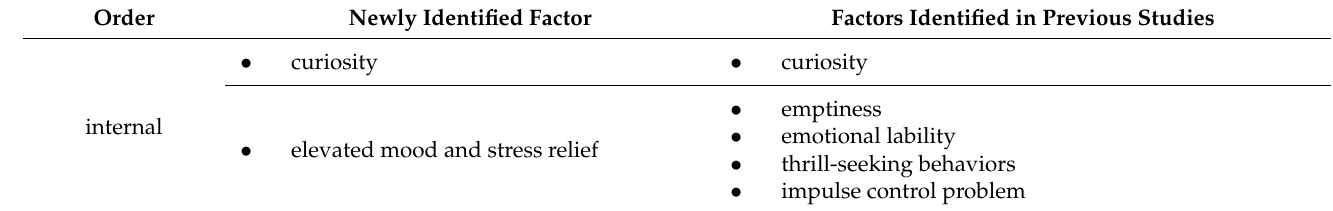
Table 3. Analysis